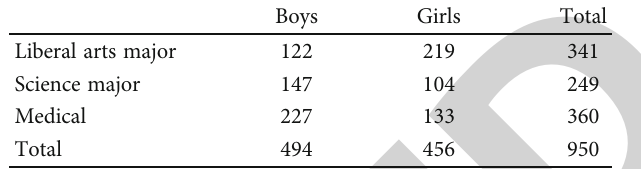
Table 1: Research objects and gender